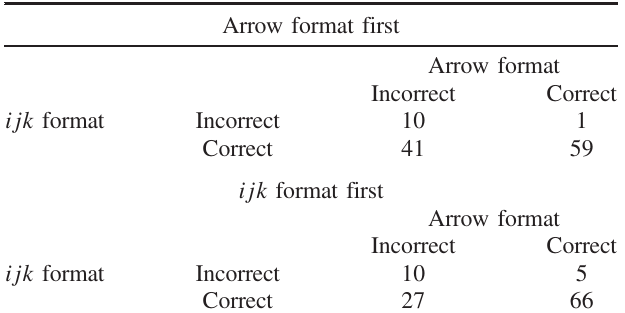
TABLE I. Within-student cross tabulations of performance on the physics context vector addition questions (Fig. 6) in the arrow format (angle or grid) and the ijk format. Cell values represent